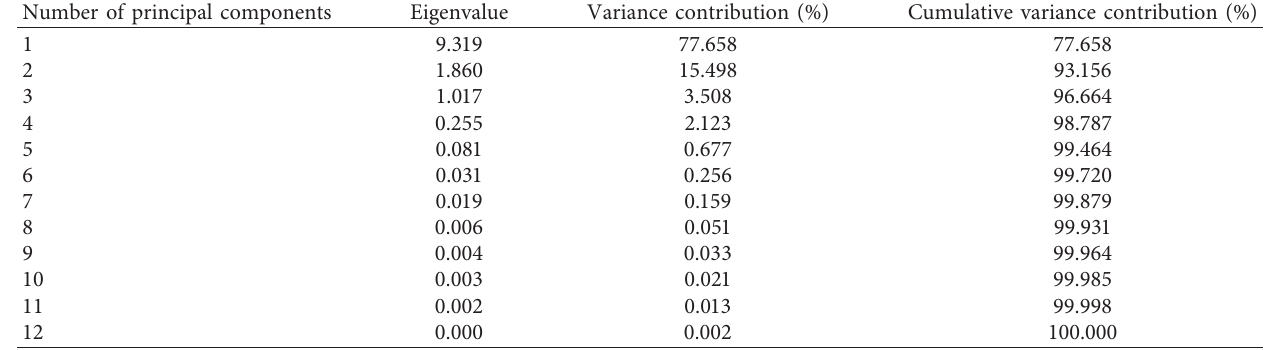
Table 6: Result of principal component analysis.